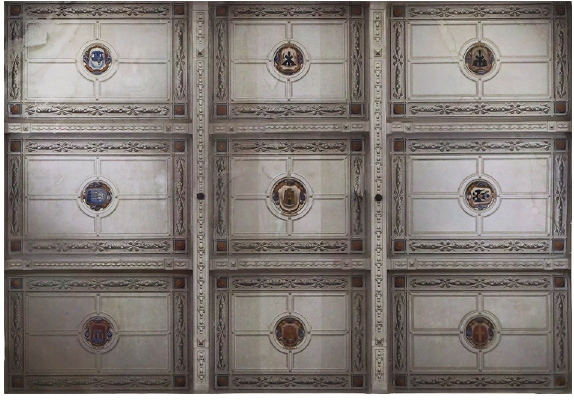
Figure 4 . Caltanissetta Centrale Station Hall ceiling orthophoto generated with Agisoft